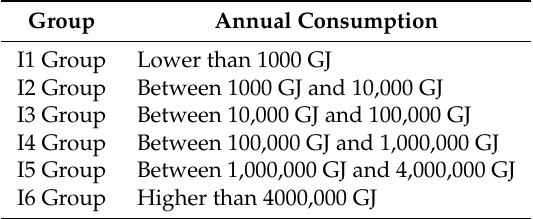
Table 7. Classification of industrial consumers, natural gas. Source: